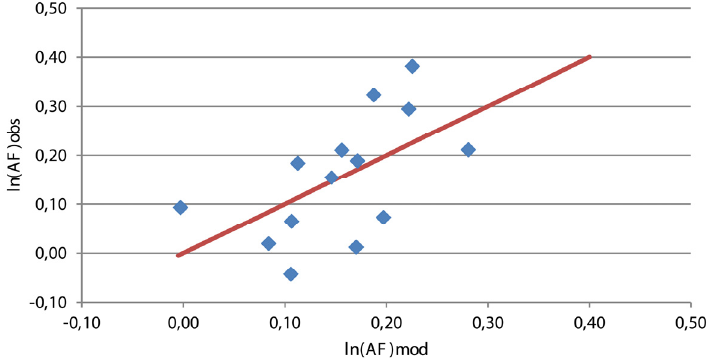
Figure 8. Comparison between the observed ln( AF ) and its